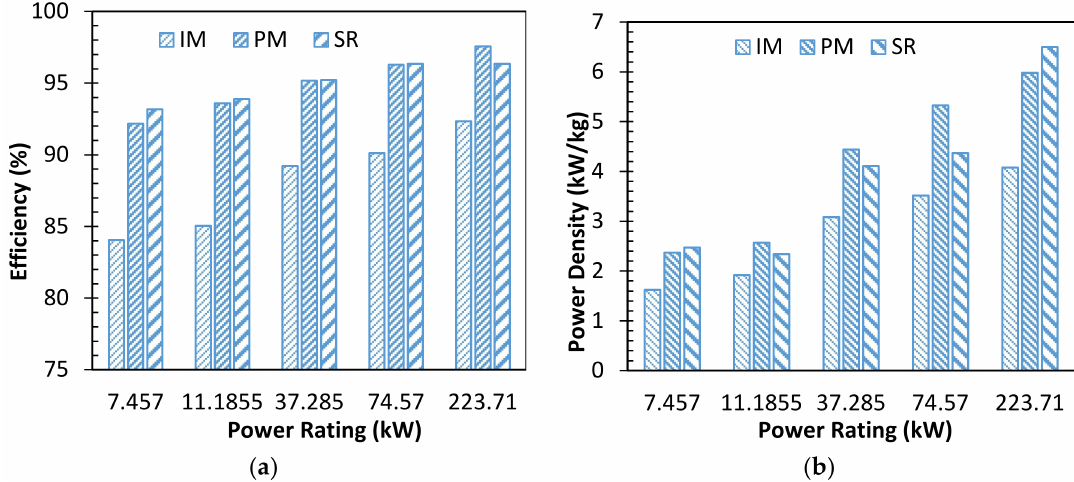
Figure 10. Efficiency ( a ) and Power density ( b ) comparison of induction machines (IM), permanent magnet (PM) machines, and switched reluctance (SR) machines at different power levels designed for a rated speed in the neighborhood of 10,000 rpm